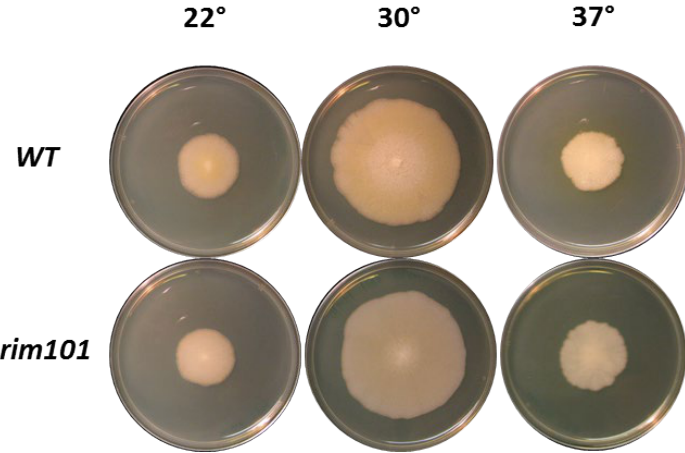
Figure 3. Radial growth of the Ashbya parental (WT) strain and the Agrim101 mutant (AWL63) on full medium plates after one week of growth at the indicated temperatures.